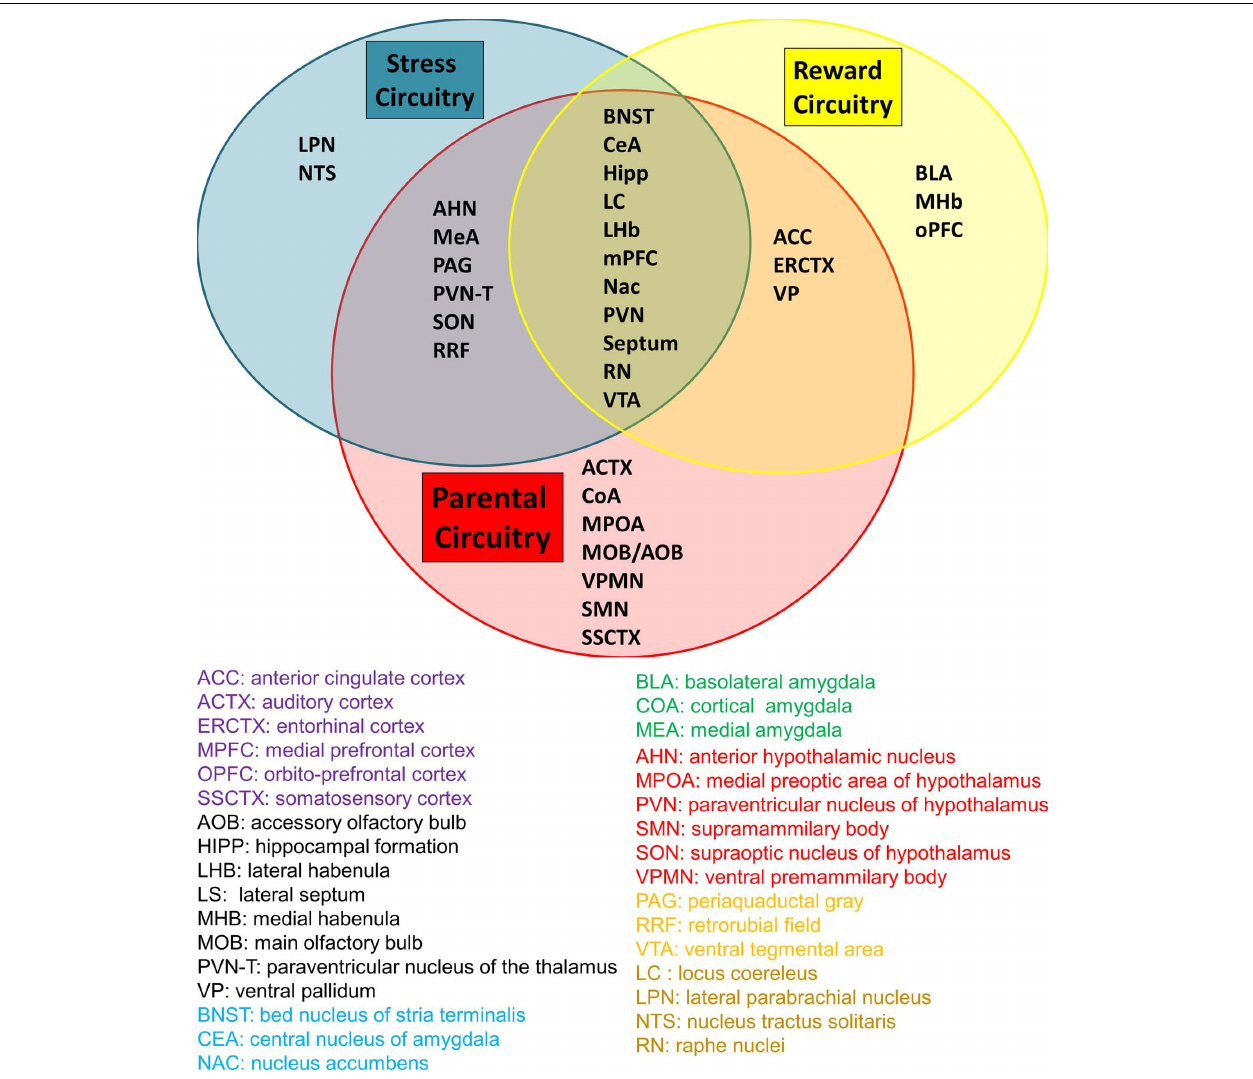
FIGURE 2 |The relationship between neurocircuits of stress, reward, and parenting. Parenting circuitry (red) shares many regions with stress (blue) and reward (yellow).The regions listed in the center have been implicated in all three circuits, suggesting that disruption in regions of one circuit can have profound impact on the functioning of the other connected circuits. It can be